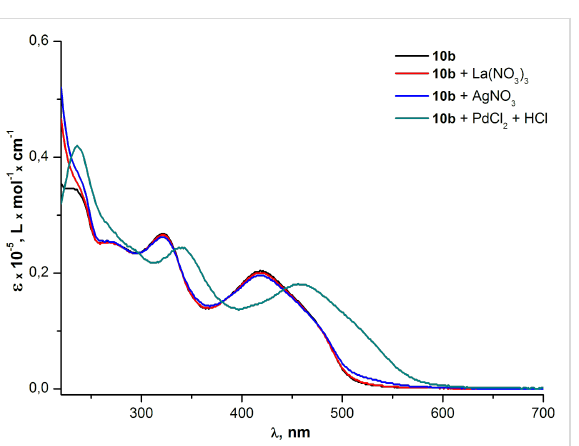
Figure 11: Emission spectra of PAE 10b in THF before and after the addition of metal